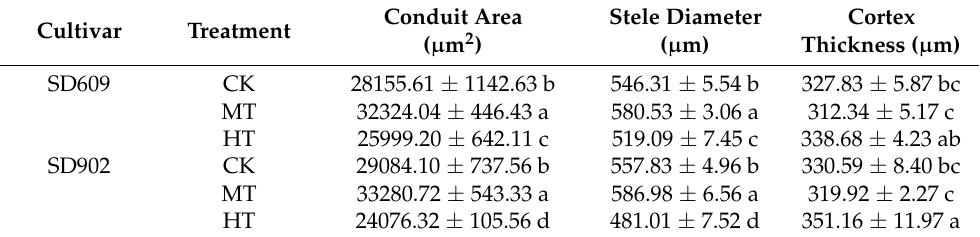
Table 1. Effect of different root zone temperatures on the root microstructure of SD609 and SD902. Cultivar